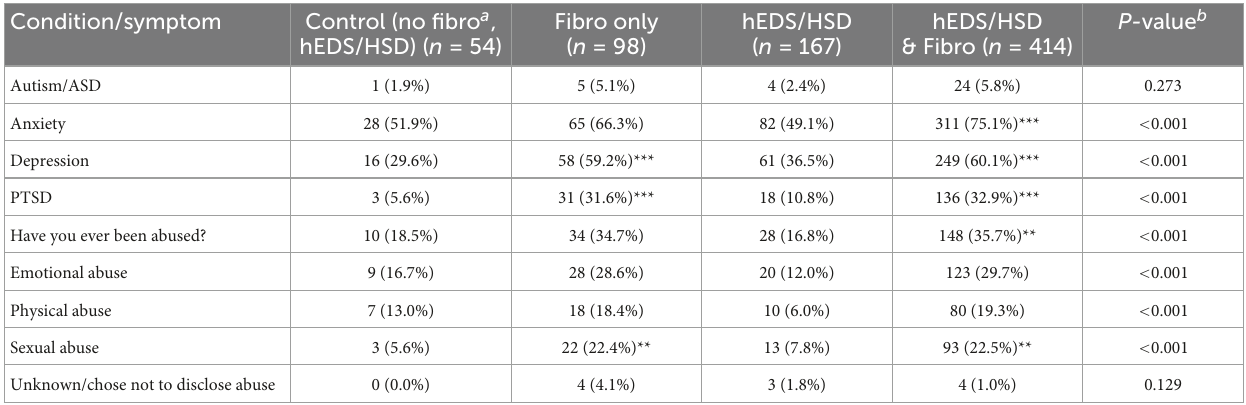
TABLE 6 Mental health issues and abuse in female and male patients diagnosed with fibromyalgia, hypermobility (hEDS or HSD) or hEDS/HSD and fibromyalgia compared to controls ( n =